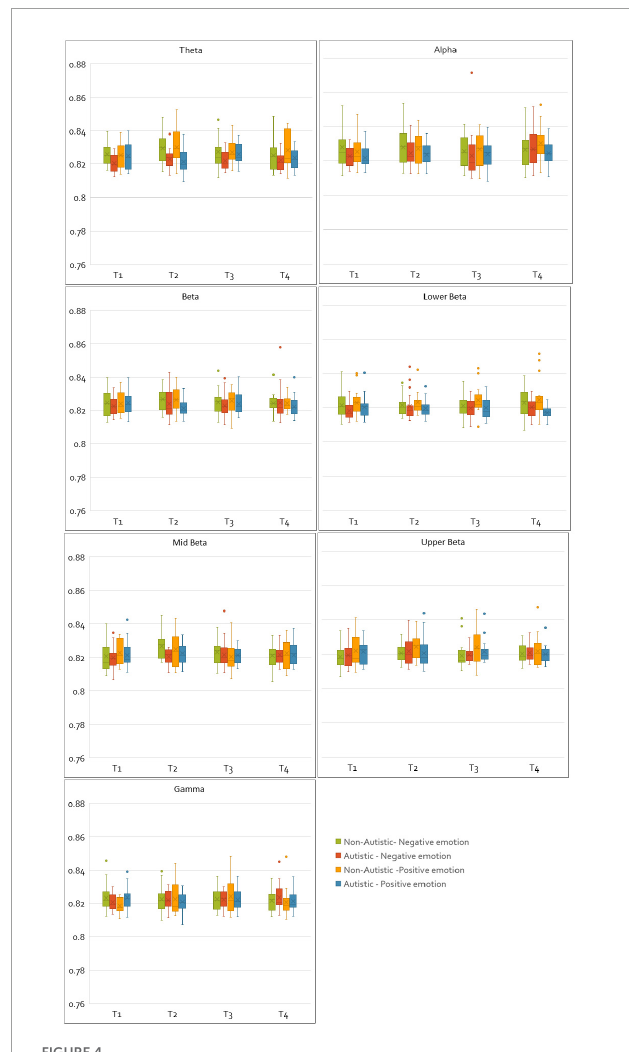
FIGURE4 Plots of normalized and integrated CPL values for the autistic and non-autistic groups. The figure shows the normalized and integrated CPL values plotted for all frequency bands, time windows and emotions (negative and positive) as box plots for the autistic and non-autistic